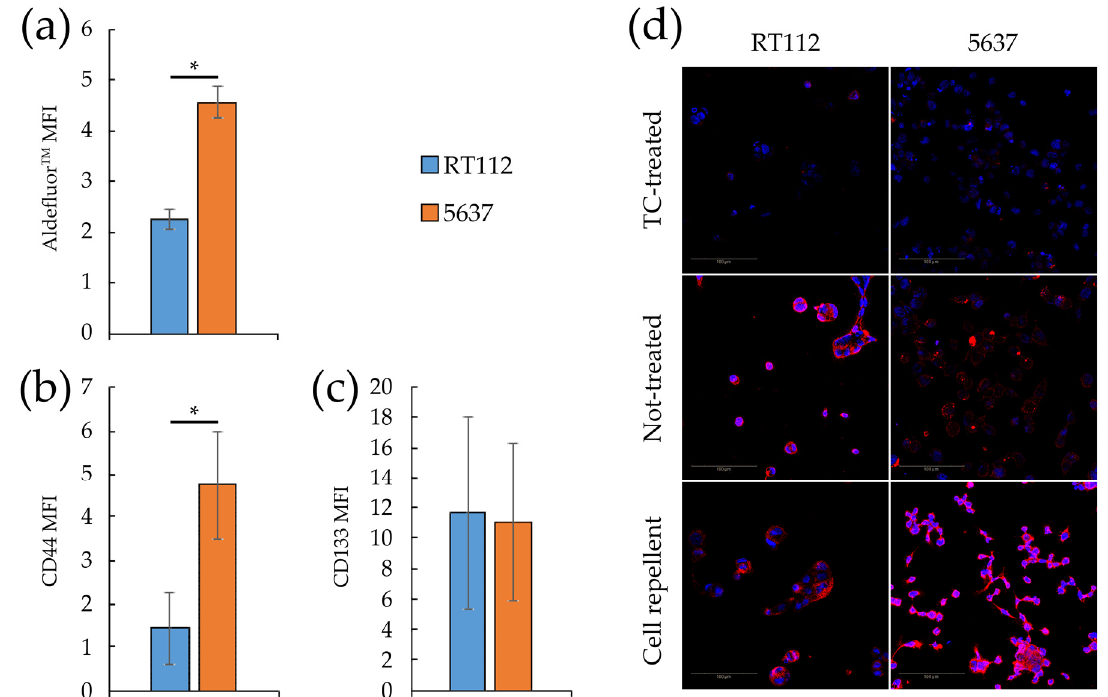
Figure 2. Stemness markers of monolayers and spheroids from RT112 and 5637 cells. ( a – c ) Median fluorescence intensity of Aldefluor TM ( a ), CD44 ( b ) and CD133 ( c ) by flow cytometry analysis on RT112 and 5637 cells grown as monolayers. Results are the mean of two ( a ) and three ( b , c ) experimental replicates. Statistical test: t -test, * for p < 0.05. ( d ) Representative images from confocal immunofluorescence (IF) microscopy of RT112 and 5637 cells using SOX2 Antibody (red) and Hoechst 33342 (blue) for nuclei. Cells were grown as monolayer or spheroids on di ff erent (Tissue culture-treated, Not-treated or Cell repellent) supports, before being seeded in adherent condition on chamber slides for IF.